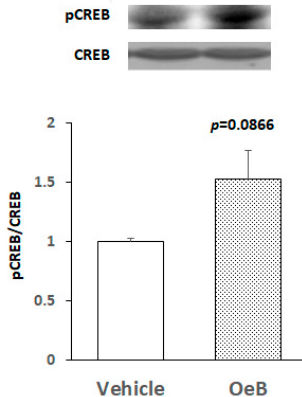
Figure 3. Effects of oenothein B on CREB activation in the hippocampal region of mice. Hippocampal tissues prepared on day 7 after the p.o. administration of oenothein B (OeB; 100 mg/kg/day) or vehicle to mice. The density ratio of phosphorylated components to total components (pCREB/CREB) in the vehicle-treated group (Vehicle) was expressed as 1.0. Values are means ± SEM ( n = 5 for each group). The Student’s t-test shows that the difference ( p ) between the 2 groups is 0.0866.